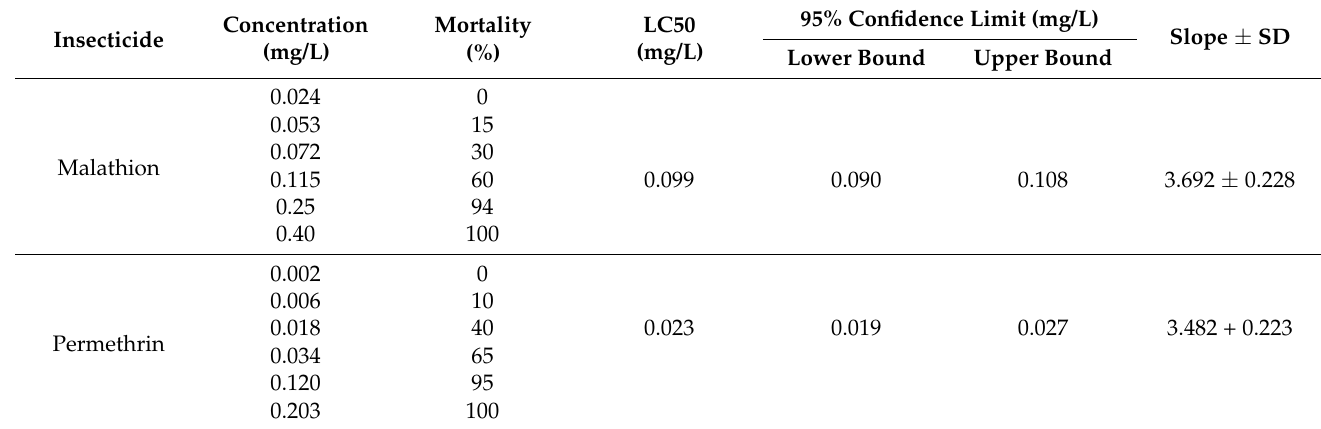
Table 5. Aedes albopictus mortality under malathion and permethrin treatments along with the calculated sub-lethal dosage (LC50).